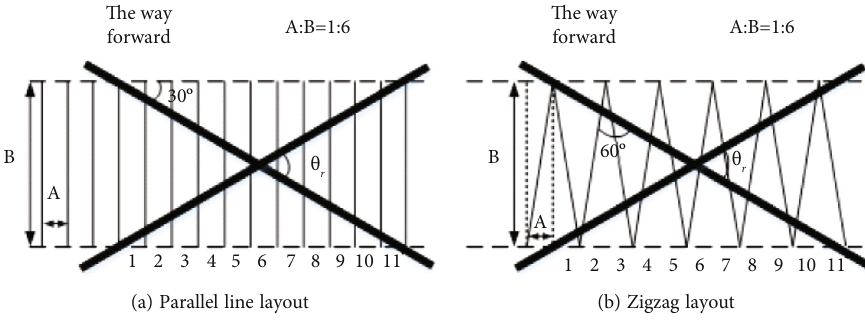
Figure 2: Layout comparison of parallel lines and